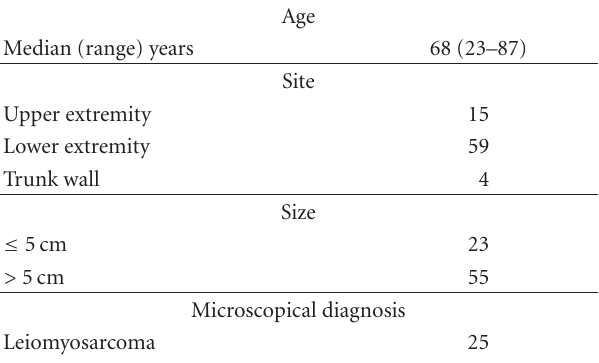
Table 1: Clinical pathological characteristics in 78 soft tissue sarco-